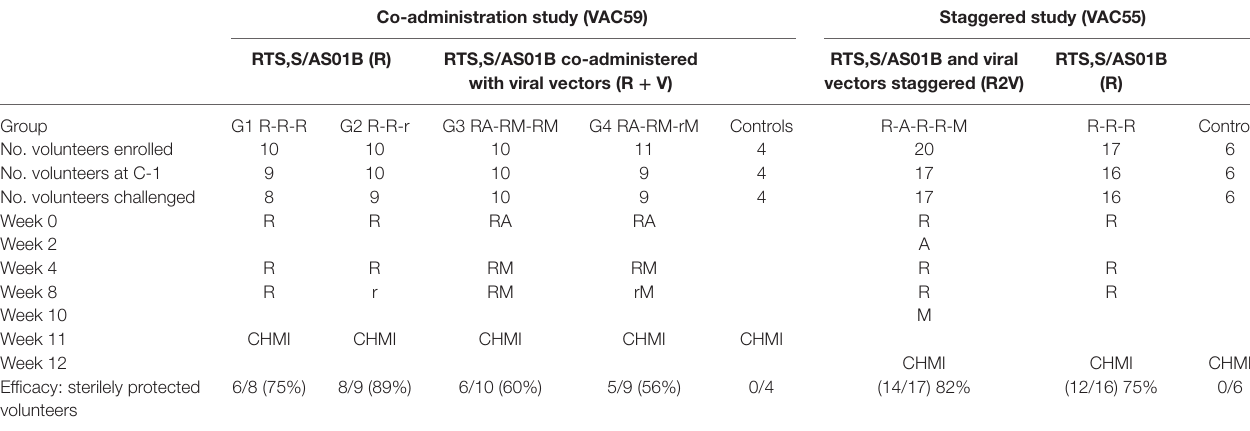
TaBle 1 | Vaccination schedules.